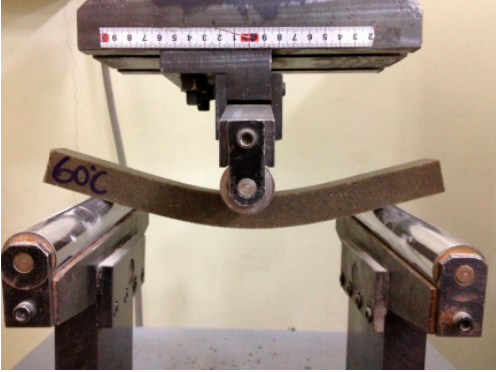
Figure 2. Setup for flexural strength tests.